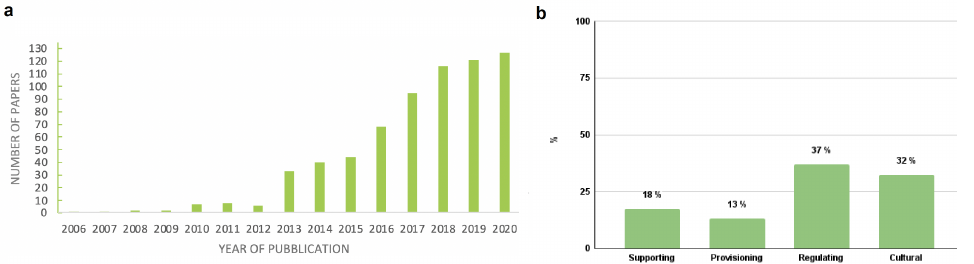
Figure 2. ( a ) Temporal trend of the papers collected in the systematic review. ( b ) The landscape services most investigated in the Review.